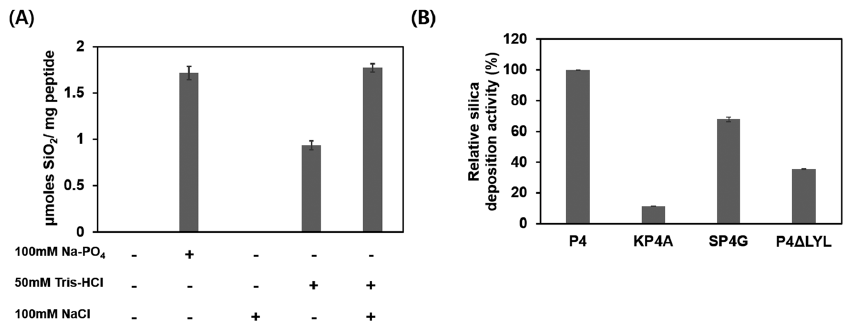
Figure 2. Characterization of P4-mediated silica precipitates. ( A ) Effect of ions and buffer composi- tions on P4-mediated silica deposition. ( B ) Analysis of P4 residues responsible for silica deposition through comparison of silica deposition ability using P4 and its variants.